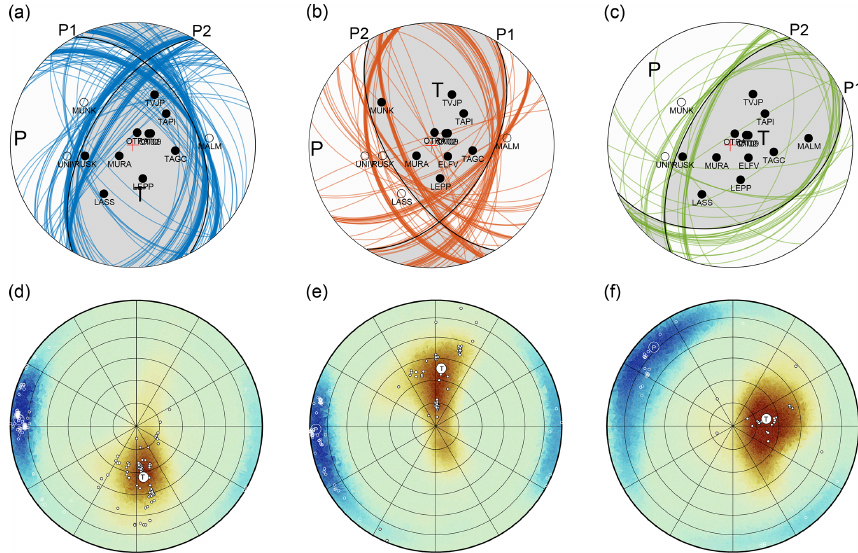
Figure 8. (a–c) Mean fault plane solutions (black lines) calculated from the best FPSs of 99 events forming family I (a) , 60 events forming family II (b) , and 27 events forming family III (c) . Contributing FPSs from which the mean is calculated are shown in blue, orange, and green, respectively. The most repetitive polarity pattern observed at each station is presented as a black or white dot for positive or negative onsets, respectively. P 1 and P 2 symbols correspond to the projections of the main and auxiliary fault planes according to which one is better oriented for failure on the Mohr circle represented in Fig. 10. (d–f) For each of the families, the mean P and T axes as well as axes of contributing FPSs are plotted as big and small white dots, respectively. The HASH-derived uncertainties (95% confidence interval) of the P and T axis of all events within each family are shown using a blue and brown coloring scale, respectively.